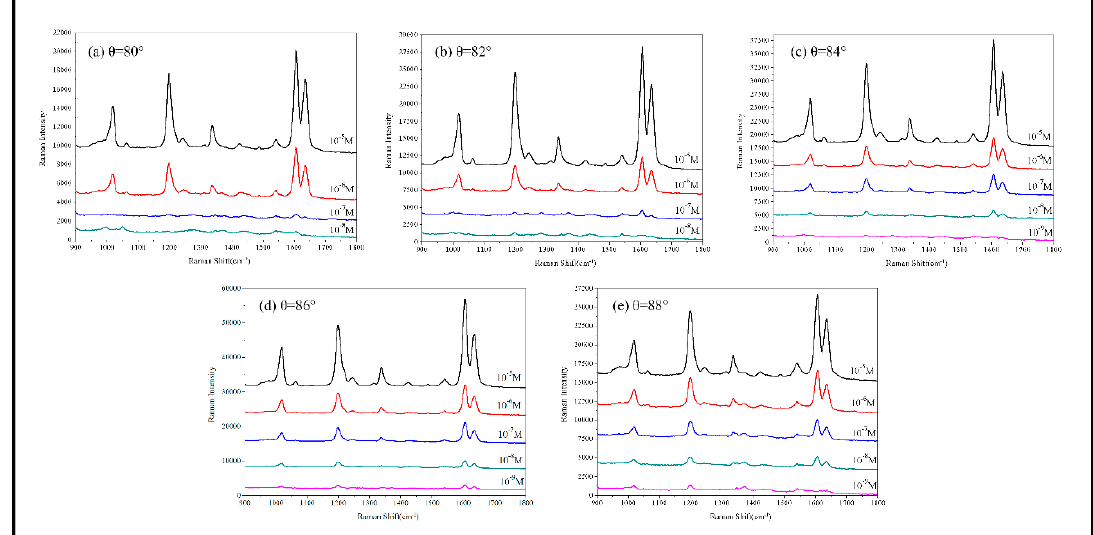
Table 2. Assignments of SERS bands of BPE.